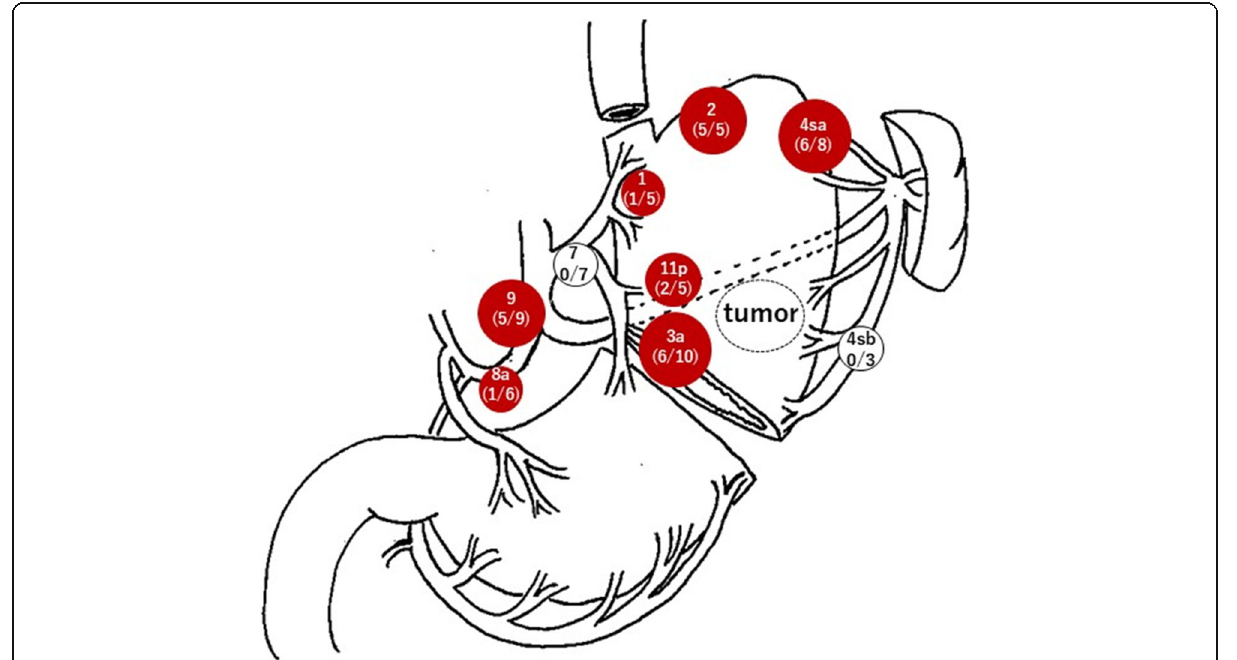
Fig. 5 Lymph node mapping. Lymph node metastasis was widely seen in almost all lymph node stations except for stations #4sb and #7 (red